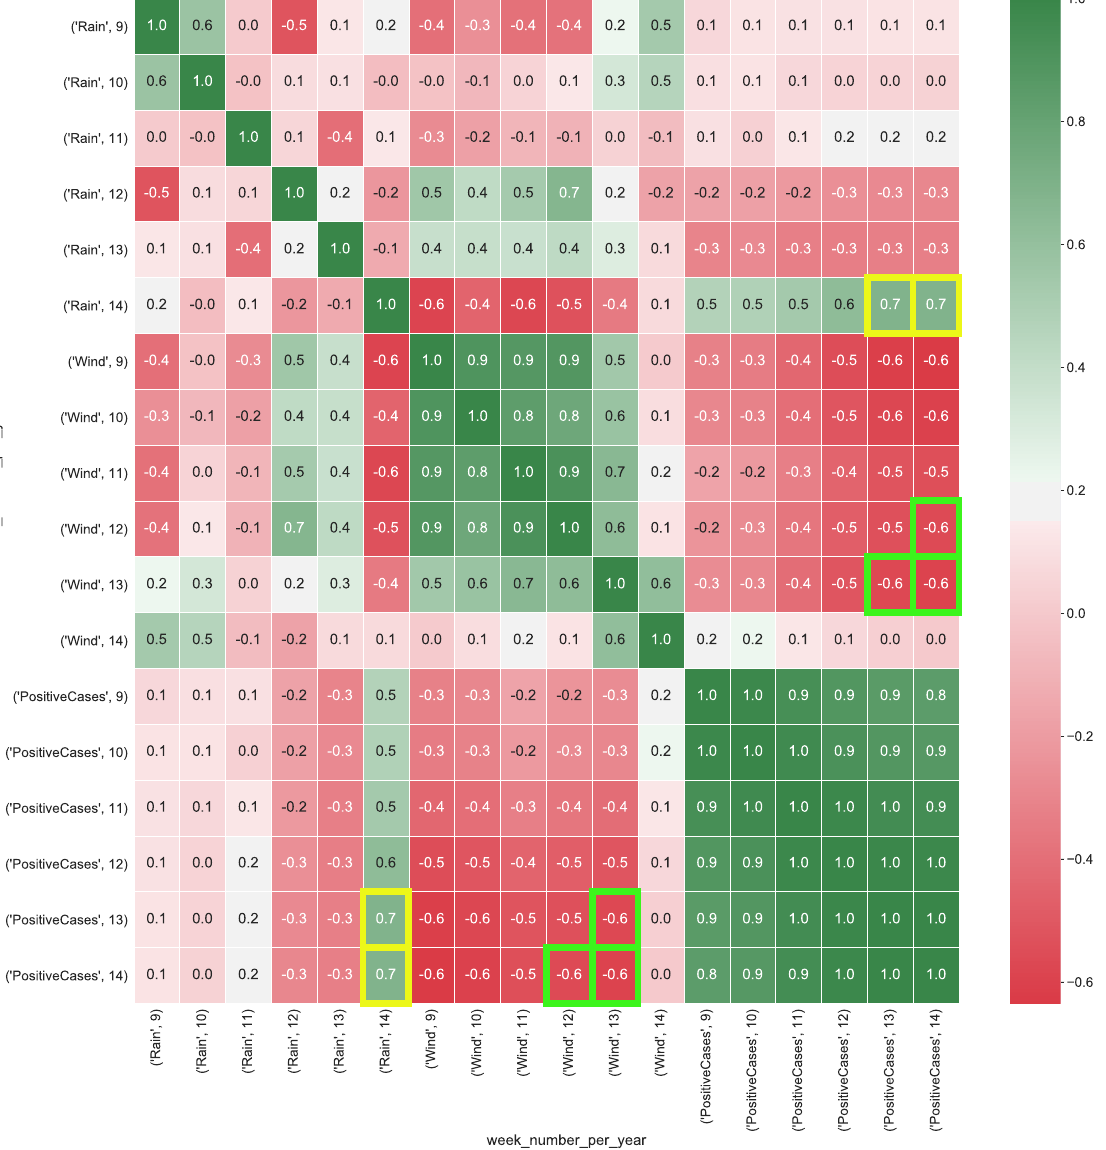
Figure 8. Heatmap representation of the data cube aggregating together the meteorological data for all the Italian regions and the COVID-19 data. The heatmap’s labels refer to the attribute’s measured value in a specific week of the year. For instance, ’PM10’, 9 refers to the level of PM10 ( µ g/m 3 ) in the air measured in the 9-th week of the year. In Figure the yellow squares highlight the strong correlation between positive cases and the presence of rain, whereas green squares show the strong negative correlation between wind and the number of positive